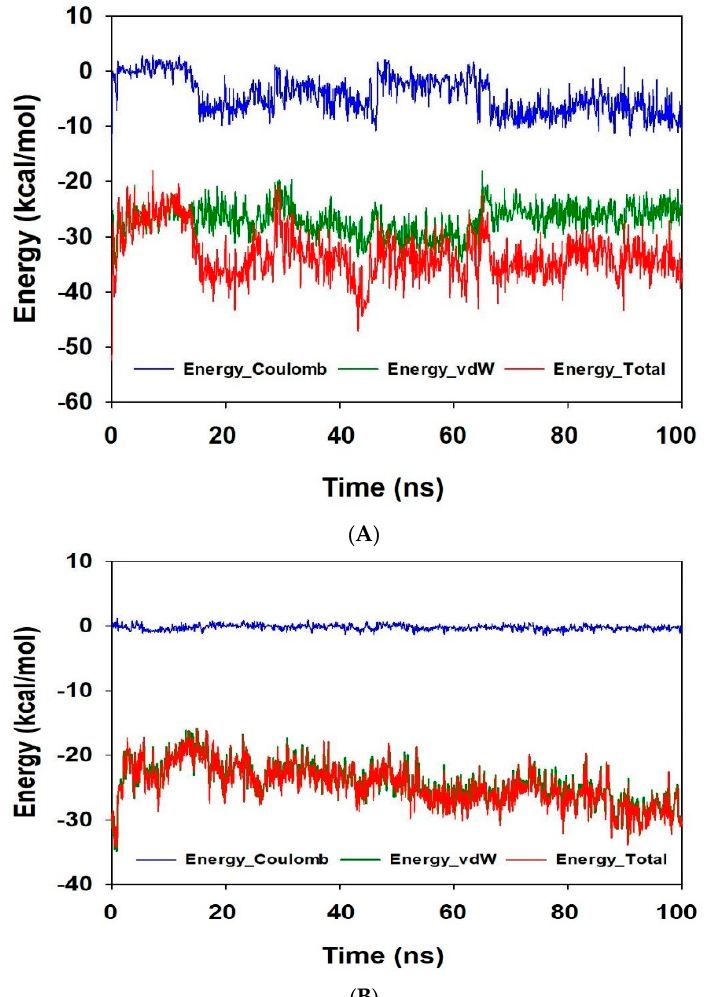
Figure 4. Energy plots of NADPH oxidase complexed with ( A ) α -bisabolol and ( B ) diallyl trisulfide.